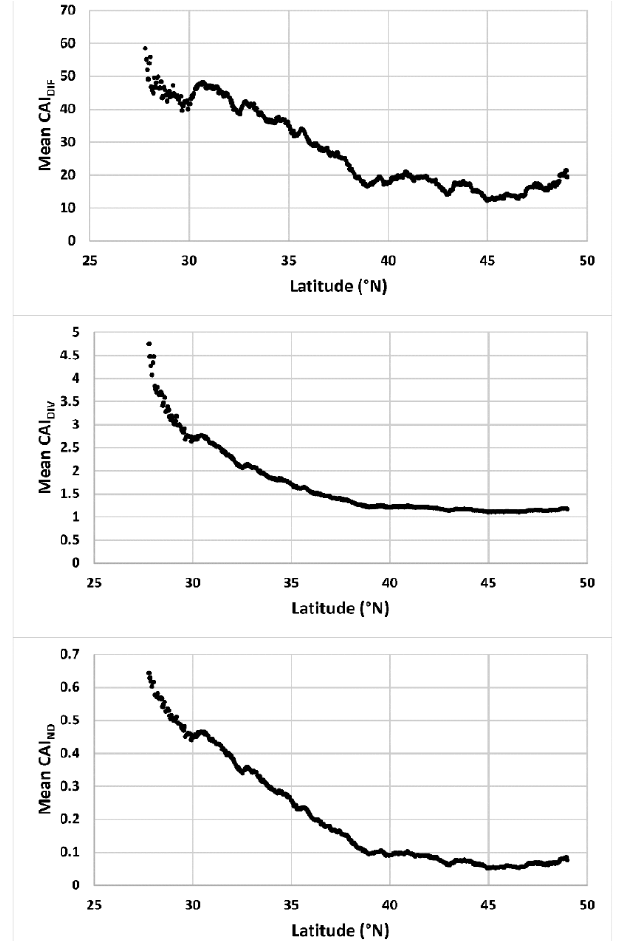
Figure 2. Latitudinal gradients of averaged climatic adaptation indices (CAIs) for the eastern Humid Temperate Domain in the U.S. (Cf. Figure 1f). The three CAIs are respectively developed through difference (DIF), division (DIV) and normalized difference (ND) of observed and modeled phenologies.